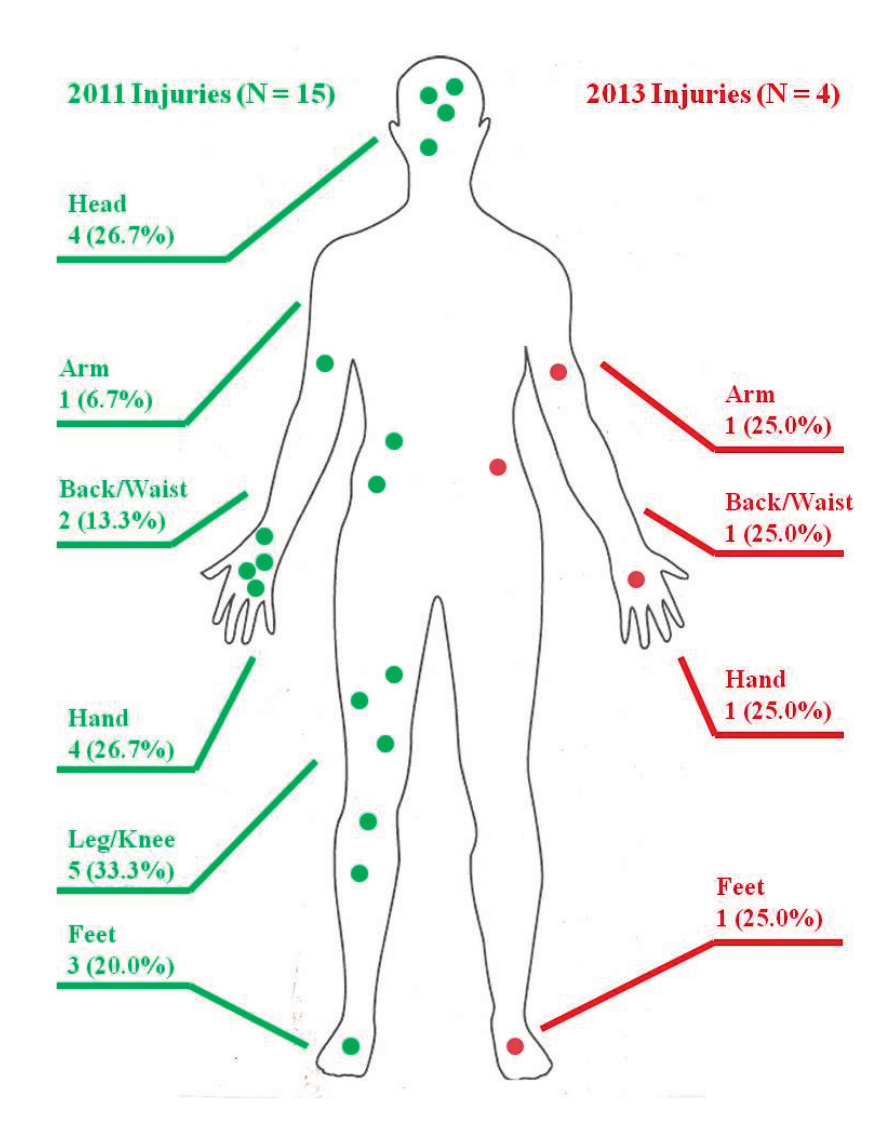
Figure 1. Body injury locations and frequencies for worst injuries in 2011* and 2013**.